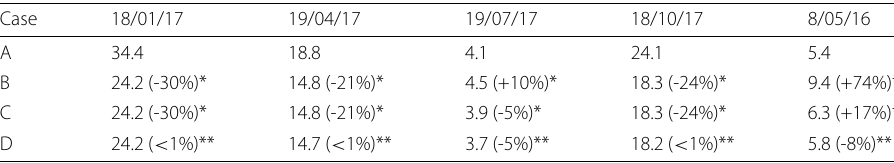
Table 4 Total daily carbon emissions [kg] and variations in percentage Case 18/01/17 19/04/17 19/07/17